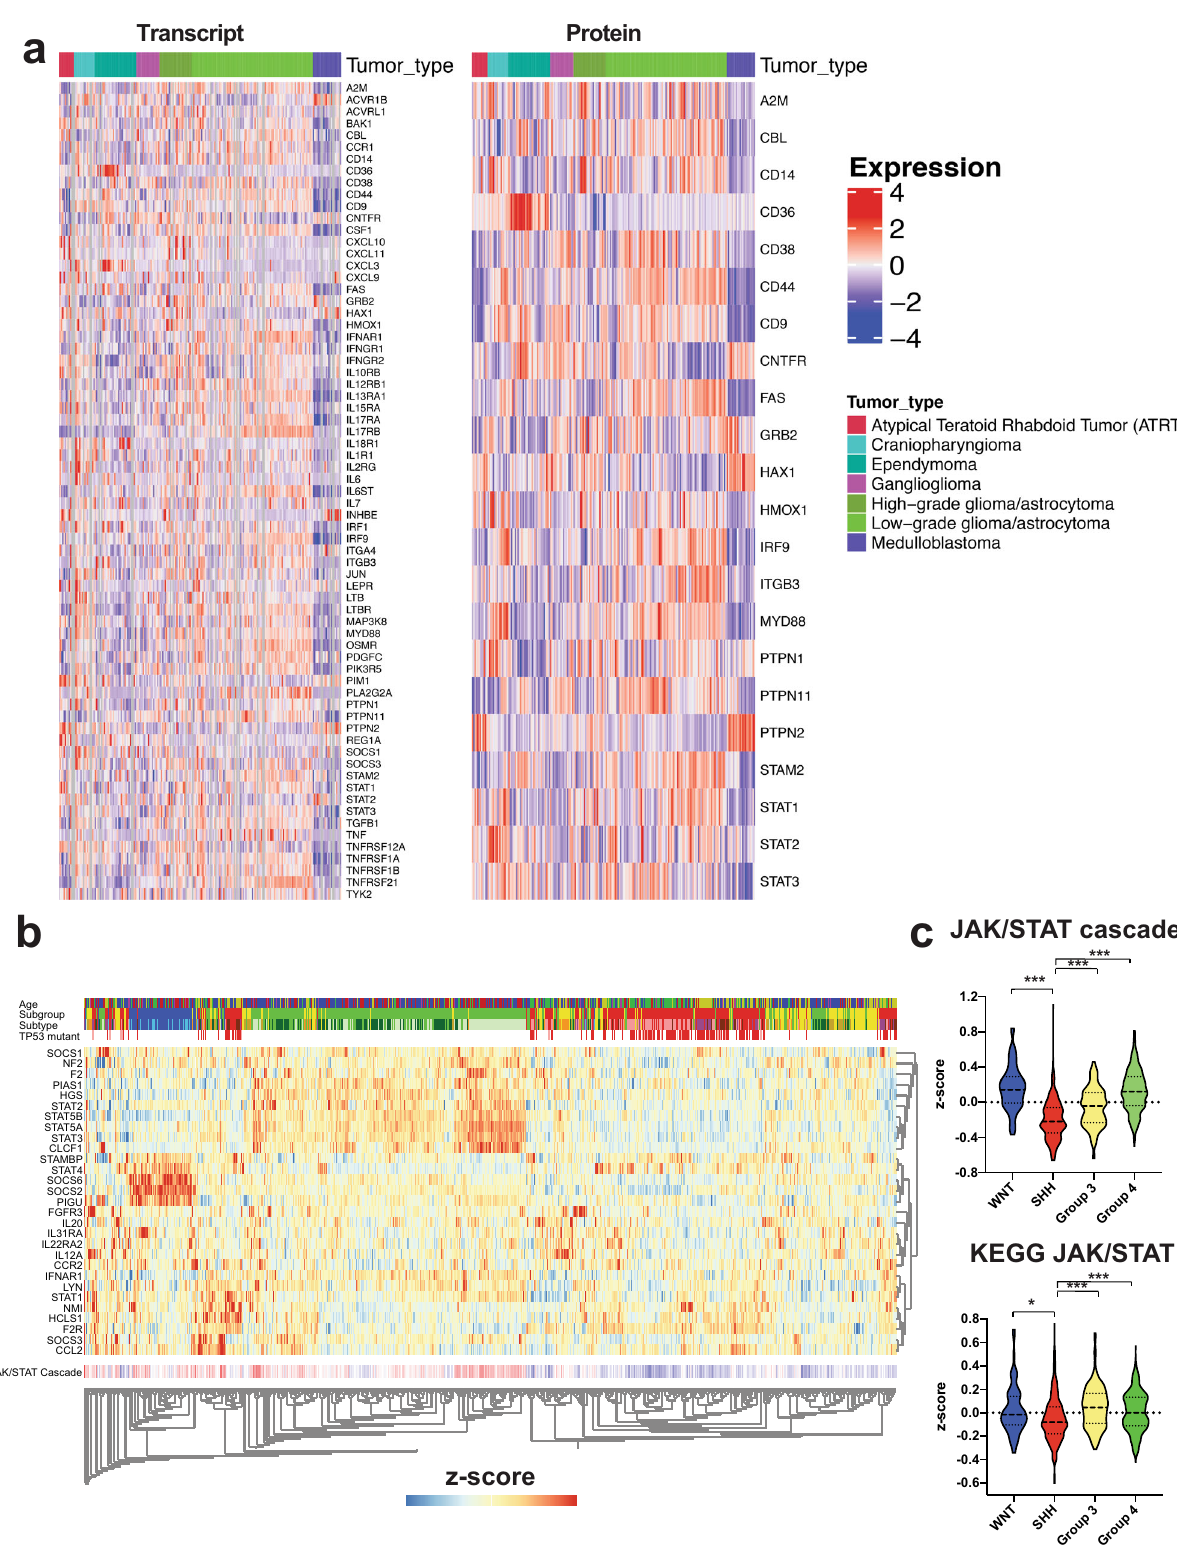
RNA sequencing reveals signi fi cant molecular changes in SHH MB tumorspheres following MEK inhibition or dual MEK and JAK/STAT3 pathway inhibition . As dual JAK/STAT3 + MEK inhibition reduced tumorsphere size and cell migration, we next performed RNA-seq on selumetinib and/or pacritinib treated UI226 tumorspheres to characterize the sustained